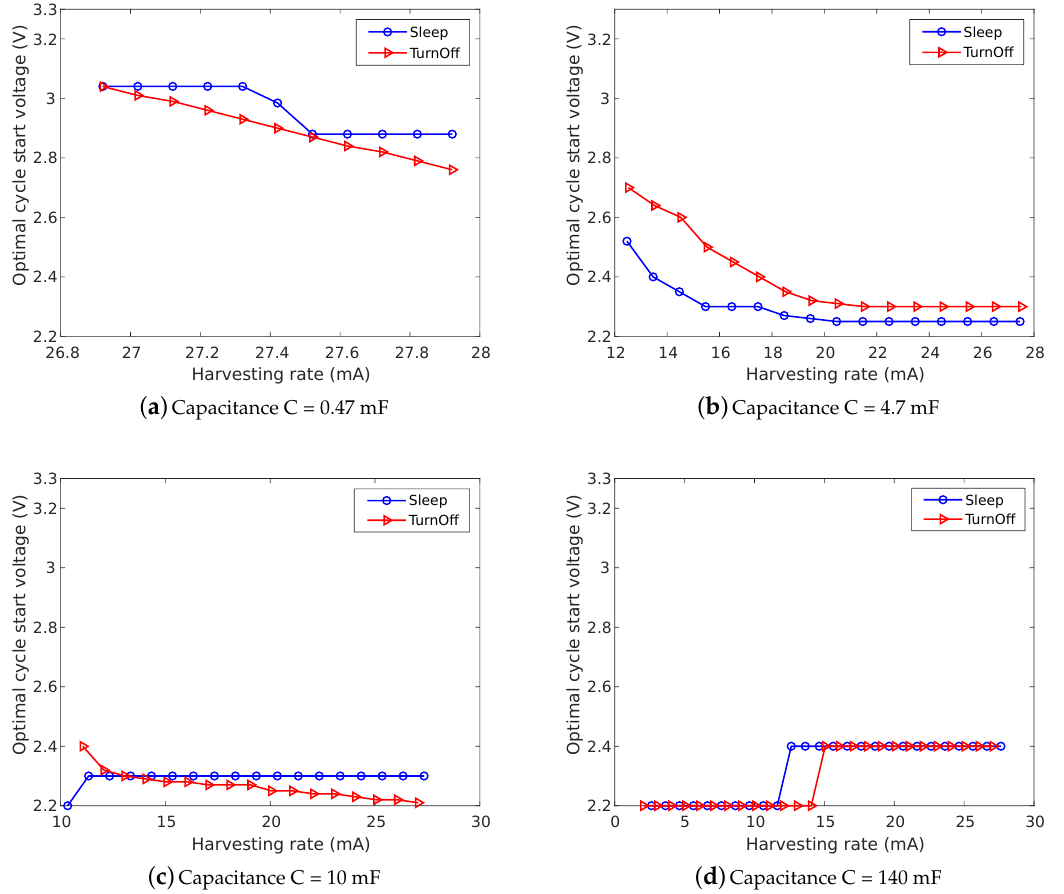
Figure 12. Optimal cycle start voltage for different capacitance including all considered